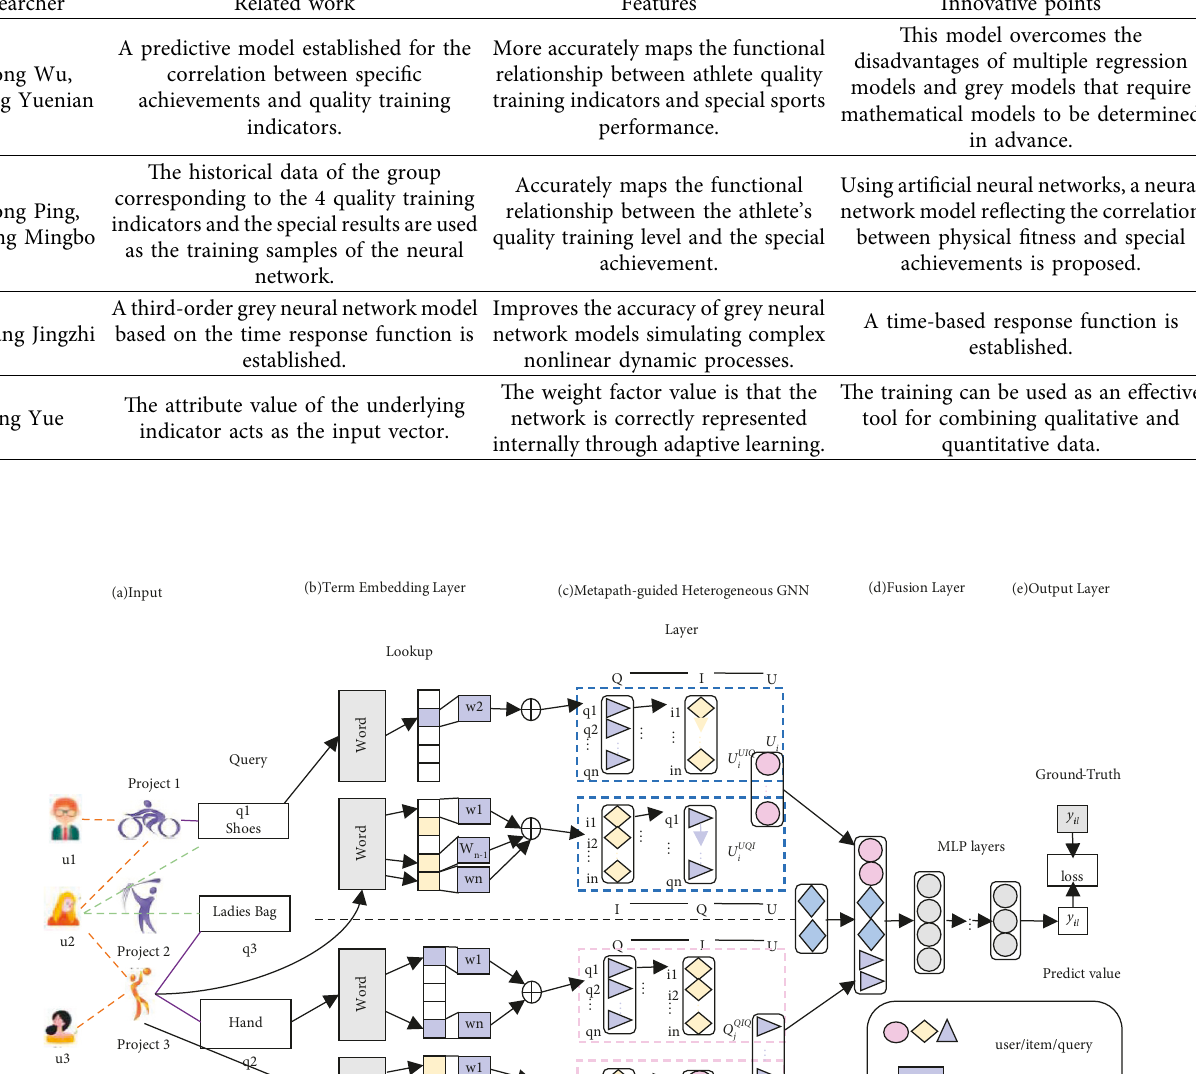
Table 1: Research progress and summary of key work.